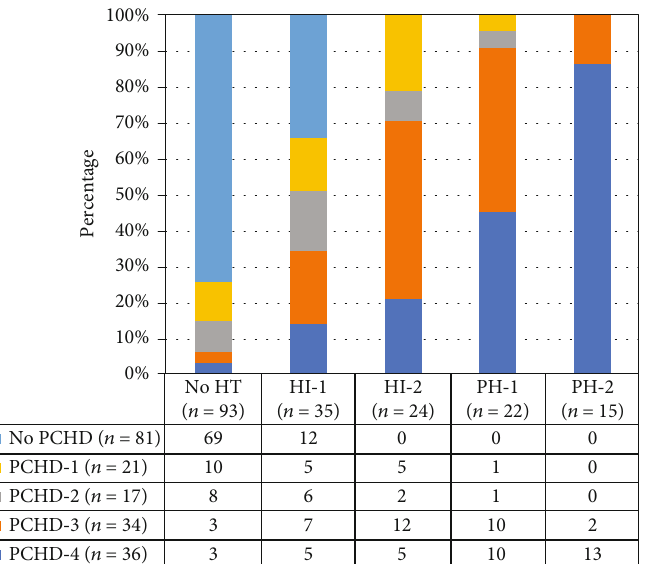
Figure 3: The correlation between the classi fi cations of PCHD and HT.